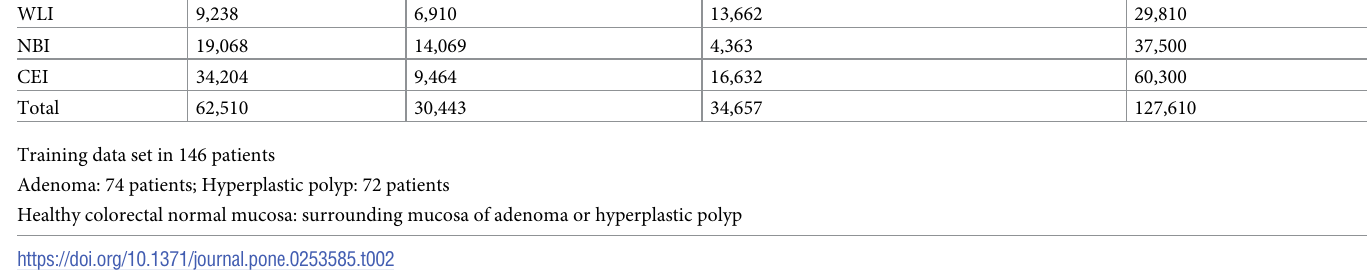
Table 2. The number of images with WLI, NBI, and CEI in data. Adenoma Hyperplastic polyp